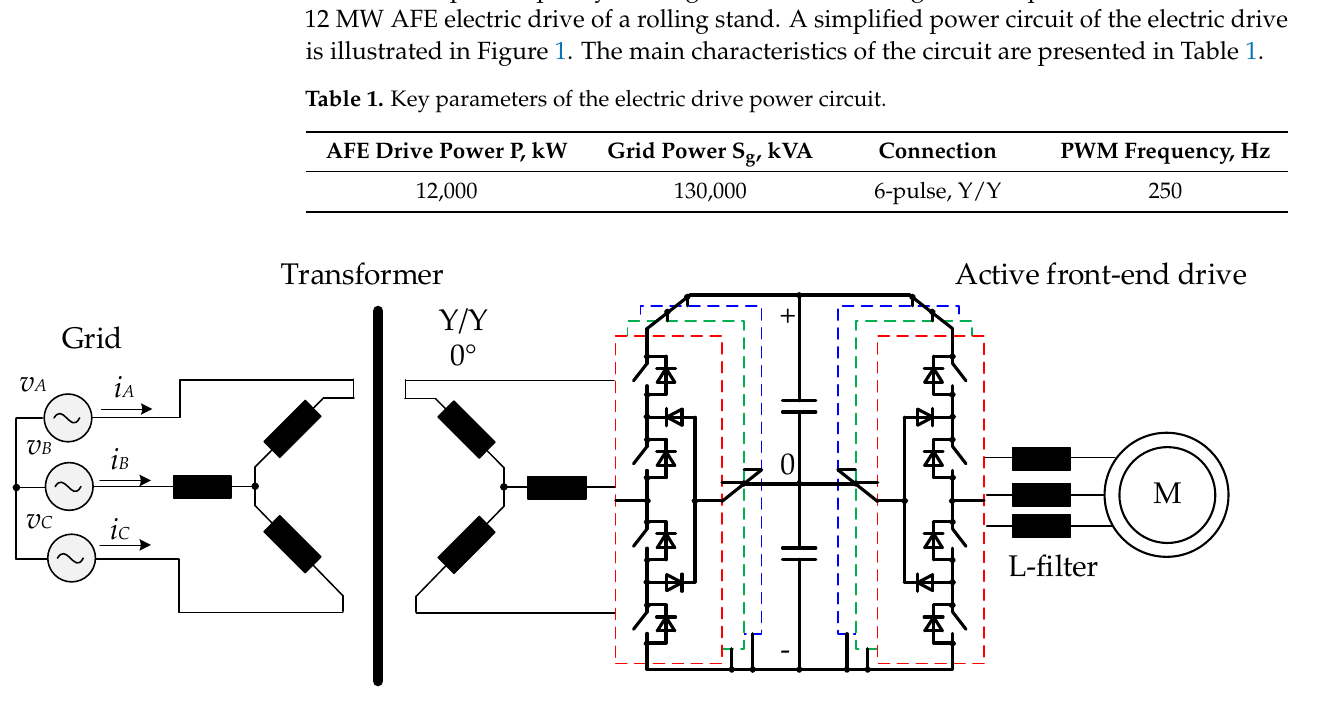
Figure 1. Six-pulse electric drive power circuit connection.